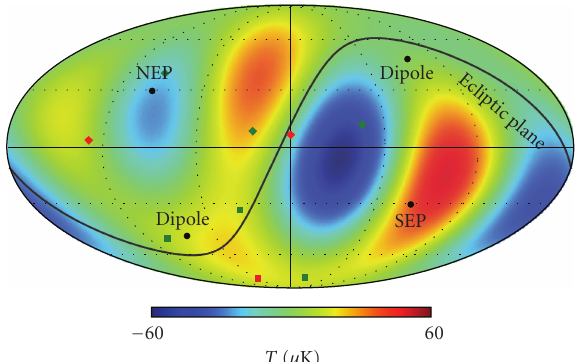
Figure 4: Quadrupole and octopole ( (cid:2) = 2 and 3) temperature anisotropy of the WMAP sky map in galactic coordinates, shown with the ecliptic plane and the cosmological dipole. Included are the multipole vectors (solid diamonds): two for the quadrupole (red diamonds) and three for the octopole (green diamonds). We also show the four normals (solid squares) to the planes defined by vectors that describe the quadrupole and octopole temperature anisotropy; one normal is defined by the quadrupole (red square) and three by the octopole (green squares). Note that three out of four normals lie very close to the dipole direction. The probability of this alignment being accidental is about one part in a thousand. Moreover, the ecliptic plane traces out a locus of zero of the combined quadrupole and octopole over a broad swath of the sky— neatly separating a hot spot in the northern sky from a cold spot in the south. These apparent correlations with the solar system geometry are puzzling and currently